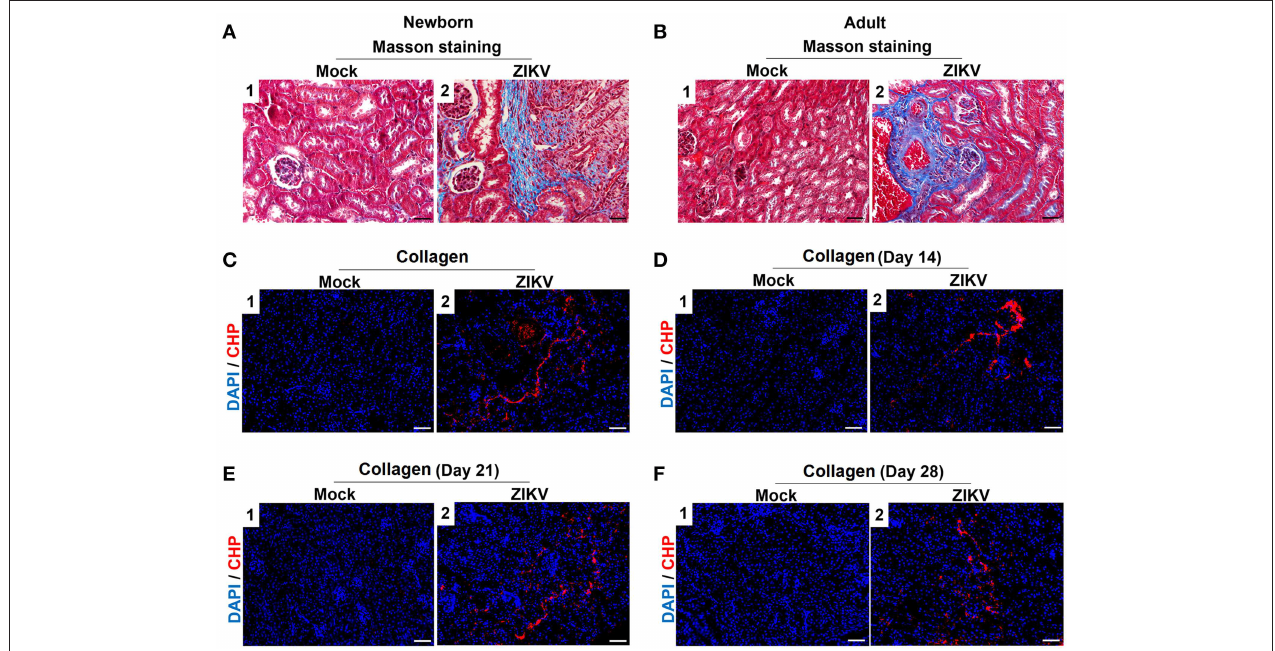
FIGURE 3 | The fibrosis changes and collagen deposition in ZIKV-infected mouse kidneys. (A,B) Images of Masson’s staining showed tubulointerstitial fibrosis (blue staining) in the kidneys of ZIKV-infected newborn mice (A) and adult mice (B) at 14 days post-infection, scale bar 40 µ m. (C–F) The kidney sections were stained with B-CHP (collagen hybridizing peptide, biotin conjugate), which were visualized using QDs-labeled streptavidin (in red) in the kidneys of ZIKV-infected newborn mice at 14 days post-infection (C) and adult mice at 14, 21, and 28 days post-infection (D–F) , scale bar 10 µ